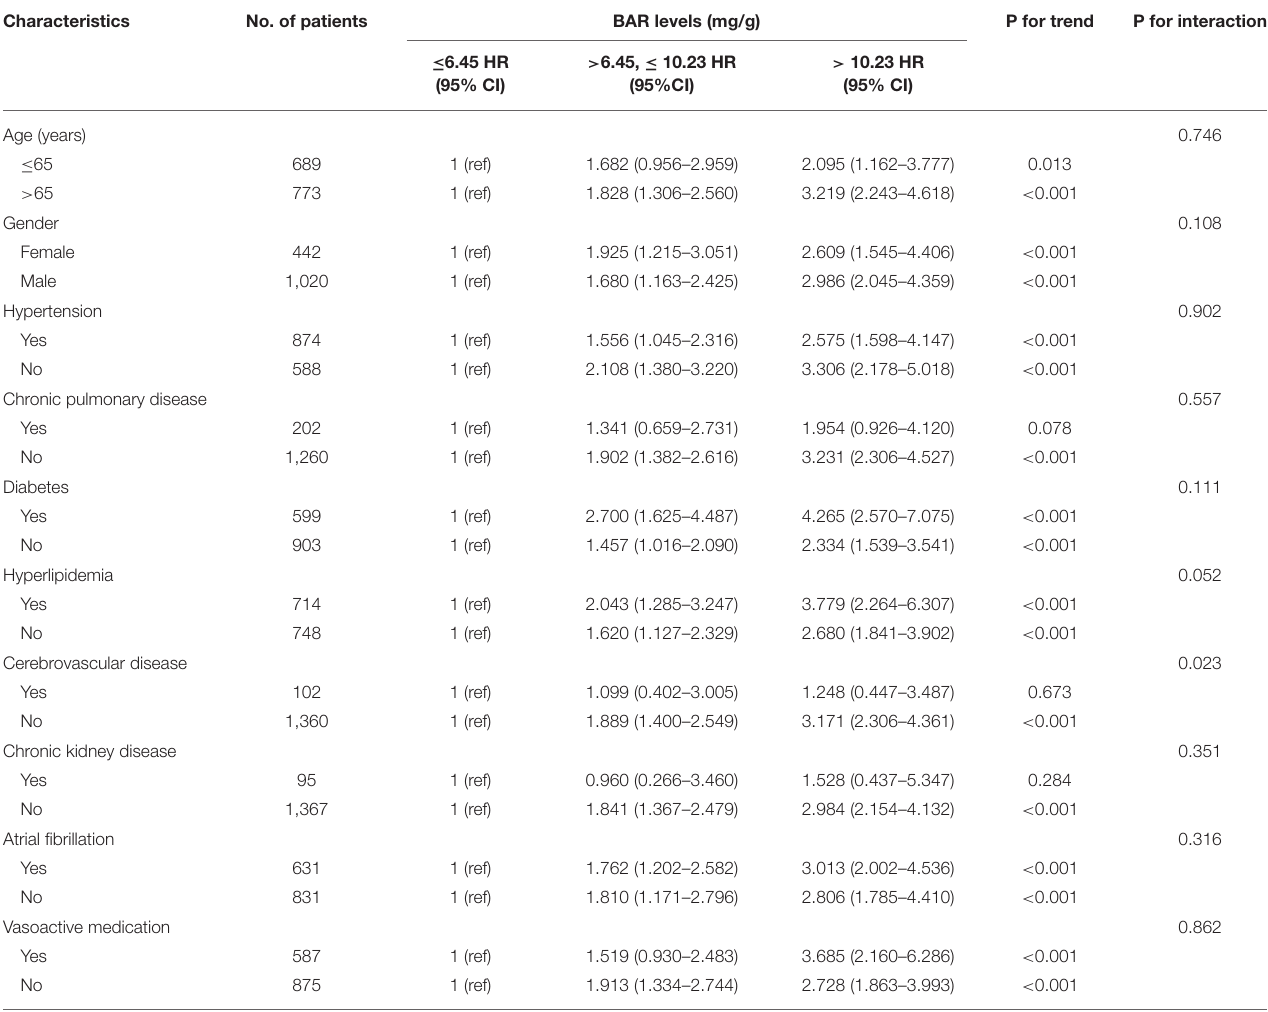
TABLE 4 | Subgroup analysis of the relationship between BAR and 4-year mortality.